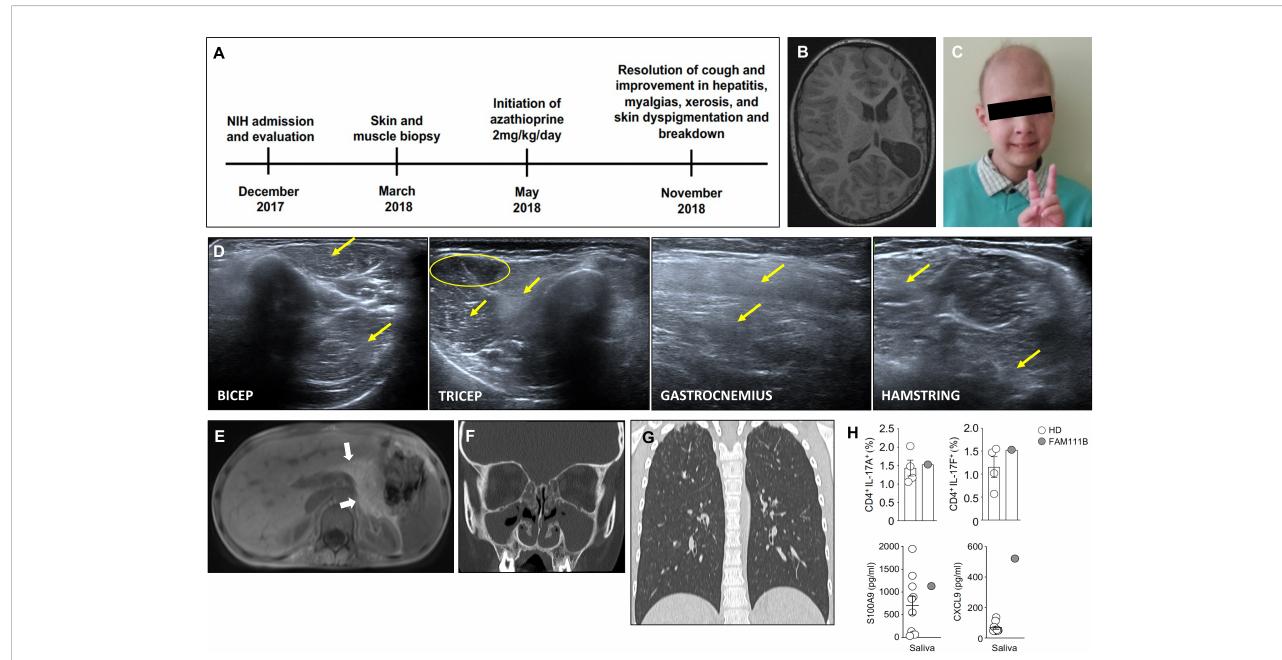
FIGURE 1 Clinical and radiographic features observed in our patient. (A) Timeline of the patient ’ s evaluation and treatment course. (B) Axial cut from T1-weighted MRI brain showing striking hemiatrophy of the entire left hemisphere, presumably due to the hemorrhagic stroke in the neonatal period. (C) Photograph of our patient at the time of evaluation at the NIH demonstrating patchy alopecia with sparse brittle hair as well as poikiloderma and conical fi ngers, which are characteristic of POIKTMP. (D) Muscle ultrasound revealing myositis evidenced by diffusely hyperechoic muscles in the upper and lower extremities. Yellow arrows point to increased echogenicity of muscle compared to a less echogenic area (yellow circle). (E) Abdominal MRI revealing complete fatty replacement of the pancreas (white arrows) consistent with the clinical history of exocrine pancreatic insuf fi ciency. (F) CT of sinuses showing complete opaci fi cation of bilateral maxillary and ethmoid sinuses. (G) Coronal (right panel) view of non-contrast chest CT revealing bilateral ground glass opacities in the apices and scattered tree-in-bud nodular opacities throughout bilateral upper and lower lobes. (H) Upper panels show the frequencies of IL-17A + (left) and IL-17F + (right) producing cells within CD4 + T cells in the peripheral blood from our patient and four healthy donors. The lower panels display levels of salivary S100A9 (left) and CXCL9 (right) from our patient and 10 healthy